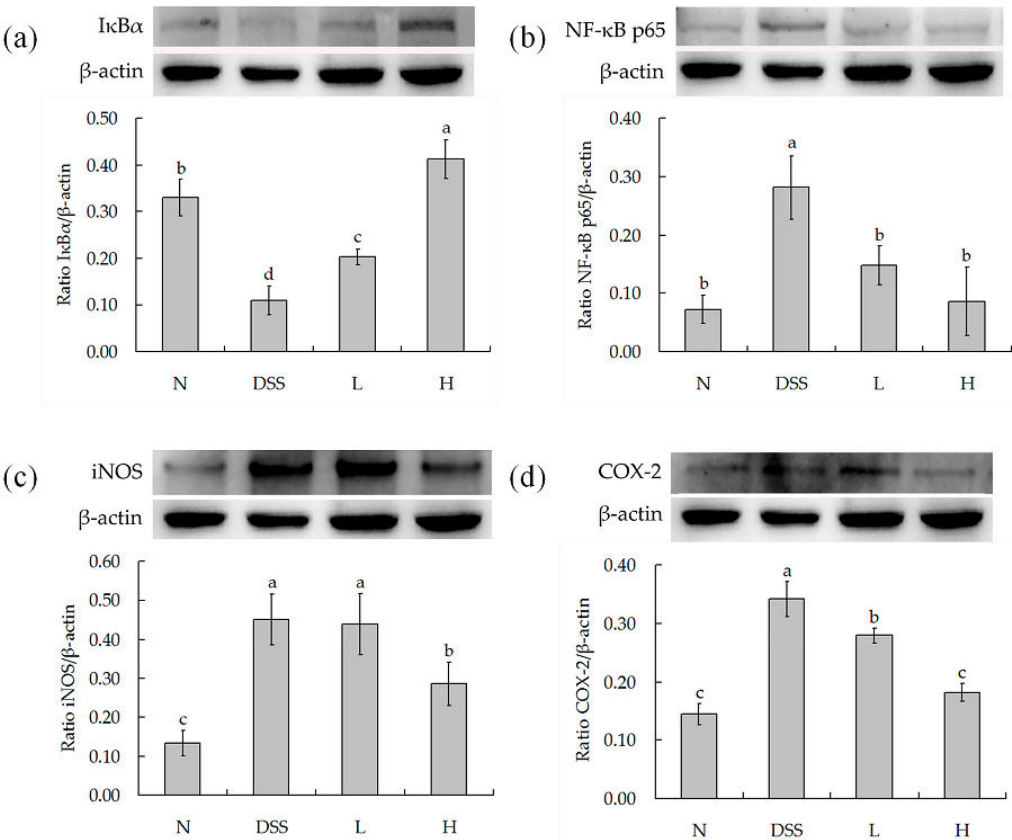
Figure 5. Protein levels in colon. ( a ) Semiquantitative analysis of protein ratio I κ B α / β -actin; ( b ) Semiquantitative analysis of protein ratio NF- κ B p65/ β -actin; ( c ) Semiquantitative analysis of protein ratio iNOS/ β -actin; ( d ) Semiquantitative analysis of protein ratio COX-2/ β -actin. N (normal group), DSS (model group), L (low dose group, 10 9 CFU/kg · bw), H (high dose group, 10 10 CFU/kg · bw); a,b,c expressed as significant level, p <